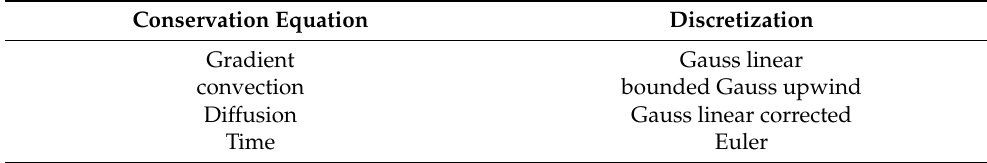
Table 1. Discretization schemes of the